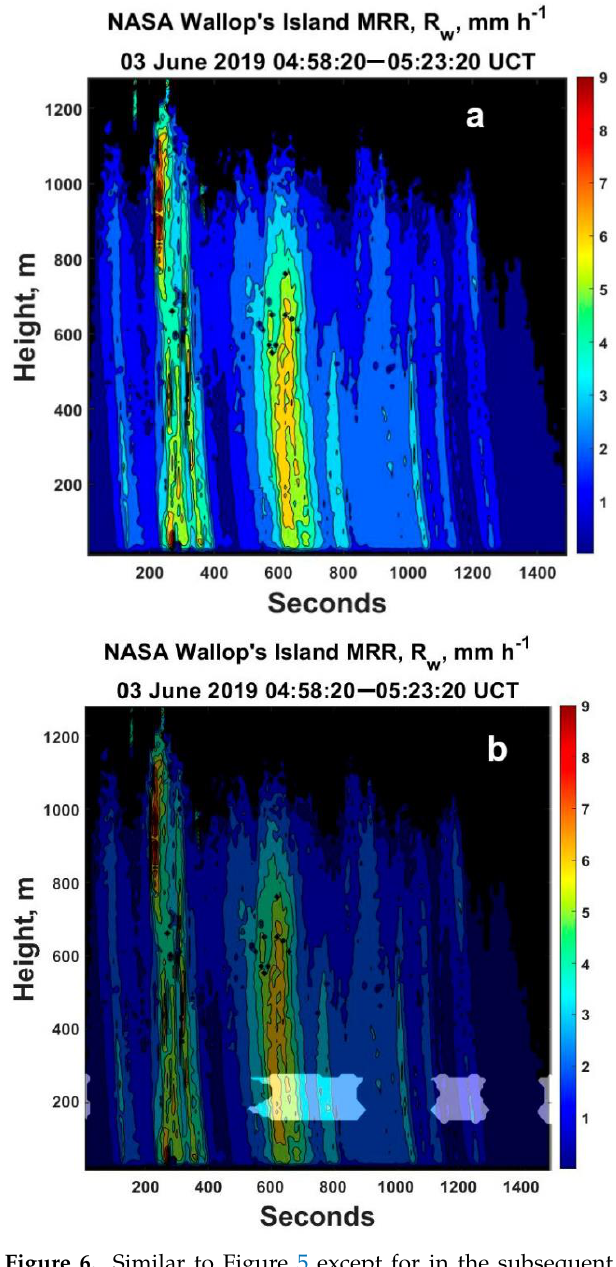
Figure 6. Similar to Figure 5 except for in the subsequent 25 min. This time, there are larger areas of statistically homogeneity, but still they are confined and found only at locations below the 300 m height.